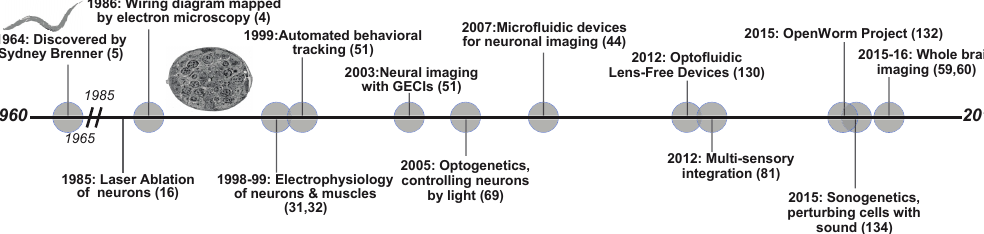
Figure 1. Timeline of neuroscience related discoveries in C. elegans . The past 60 years have resulted in